Question: Generate an informative caption for the figure above.
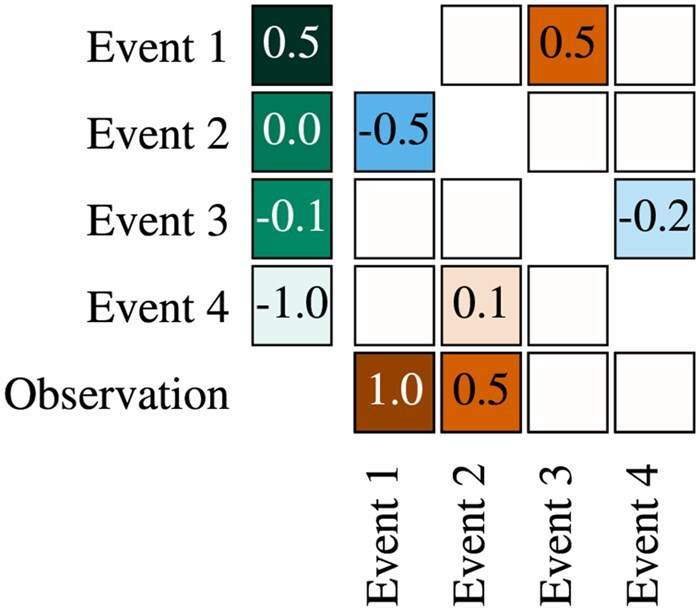
Answer: Schematic of an MHN parameter matrix for four events. Base rates θ 11 , … θ 44 of events are plotted in the left column in green. The main matrix shows influence rates θ i j between events. Orange cells visualize promoting and blue cells visualize inhibiting effects between events. For example, Event 3 promotes the accumulation of Event 1 ( θ 13 > 0 ), while Event 1 inhibits the accumulation of Event 2 ( θ 21 < 0 ). The bottom row visualizes the effect ω 1 , … , ω 4 of events on the clinical observation of a tumor.